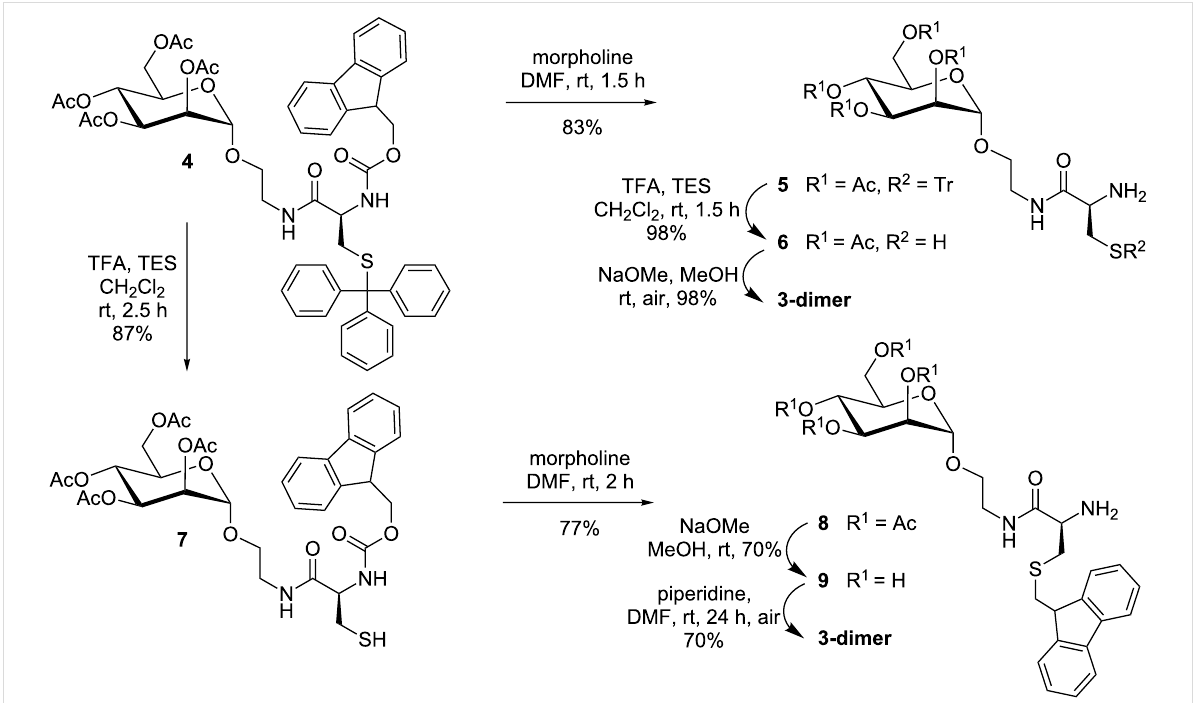
Scheme 2: To obtain the glycocystine derivative 3-dimer from the protected cysteine mannopyranoside precursor 4 , the sequence of deprotection steps matters. When the thiol function was deprotected first to give 7 , then N -Fmoc deprotection resulted in N -Fmoc → S -Fm transprotection. On the other hand, Fmoc deprotection was no problem starting from 4 with the thiol function protected.